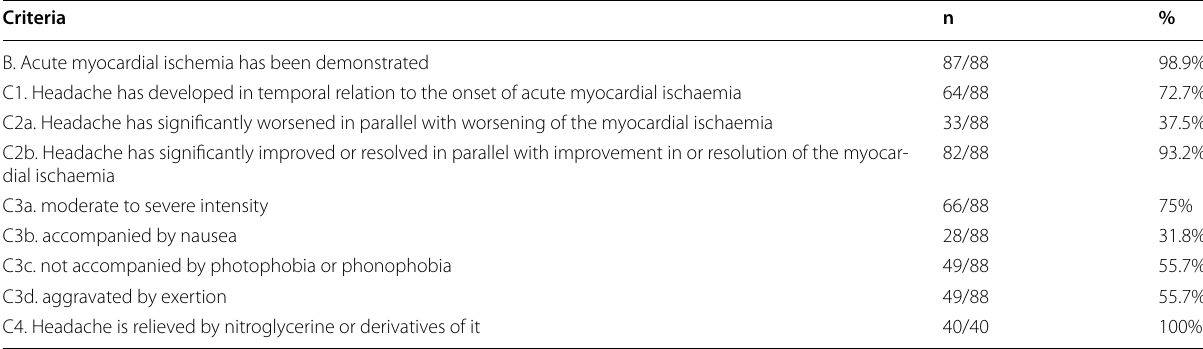
ICHD-3 international classification of headache disorders third edition